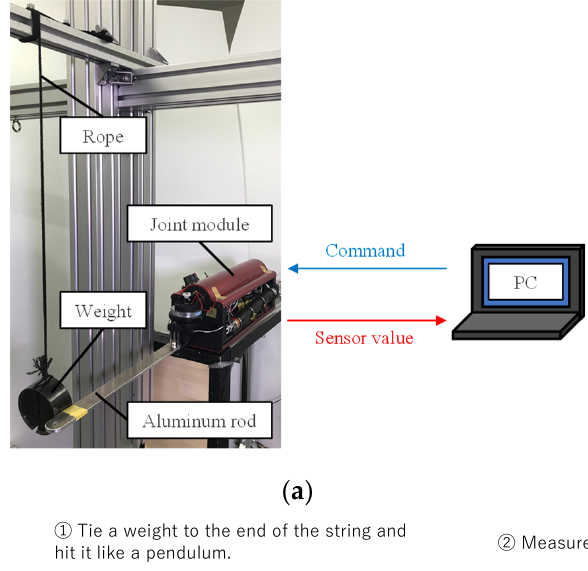
hit it like a pendulum. ② Measure until the arm stops again.